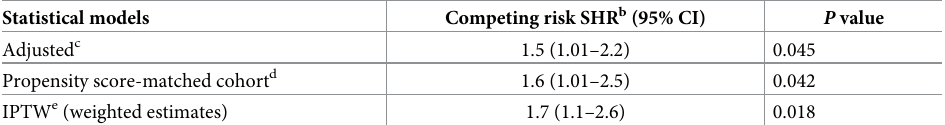
a Transplant-na¨ive waitlisted patients is the reference group. b Subhazard ratios are from competing risk models (n = 3851 and 1975 kidney transplant patients and 279 inactive status). c Adjustments in multivariate models were made for age, sex, cardiac disease, hemiplegia, chronic pulmonary disease, connective tissue disorder, diabetes, mild liver disease, cirrhosis, HIV positive, peptic ulcer, any tumor without metastasis, hemodialysis at entry, central venous catheter, peripheral vascular disease, late referral, unemployed status, time on dialysis and listing periods (1984–1987 vs. 1988–1992 vs. 1993–1997 vs. 1998–2002 vs. 2003–2007